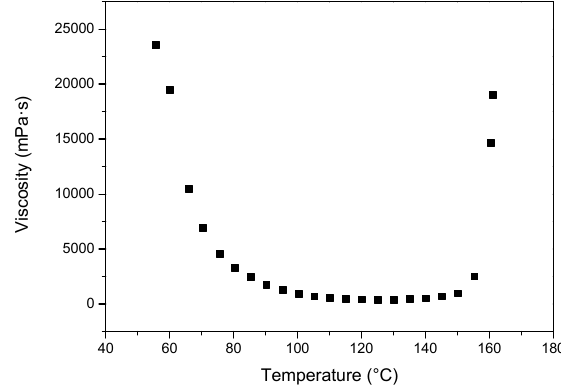
Figure 1. Viscosity-temperature curves of the resin system.